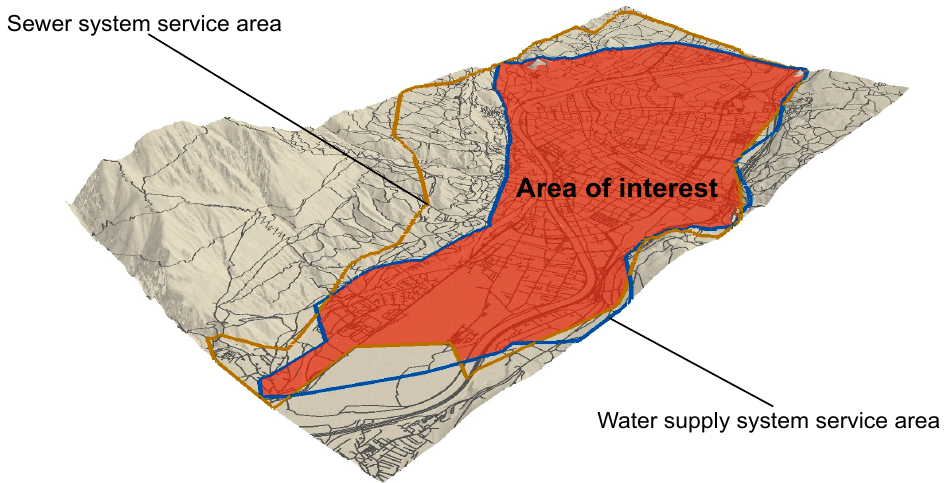
Figure 2. Area of interest defined by the service area intersection of all network types.